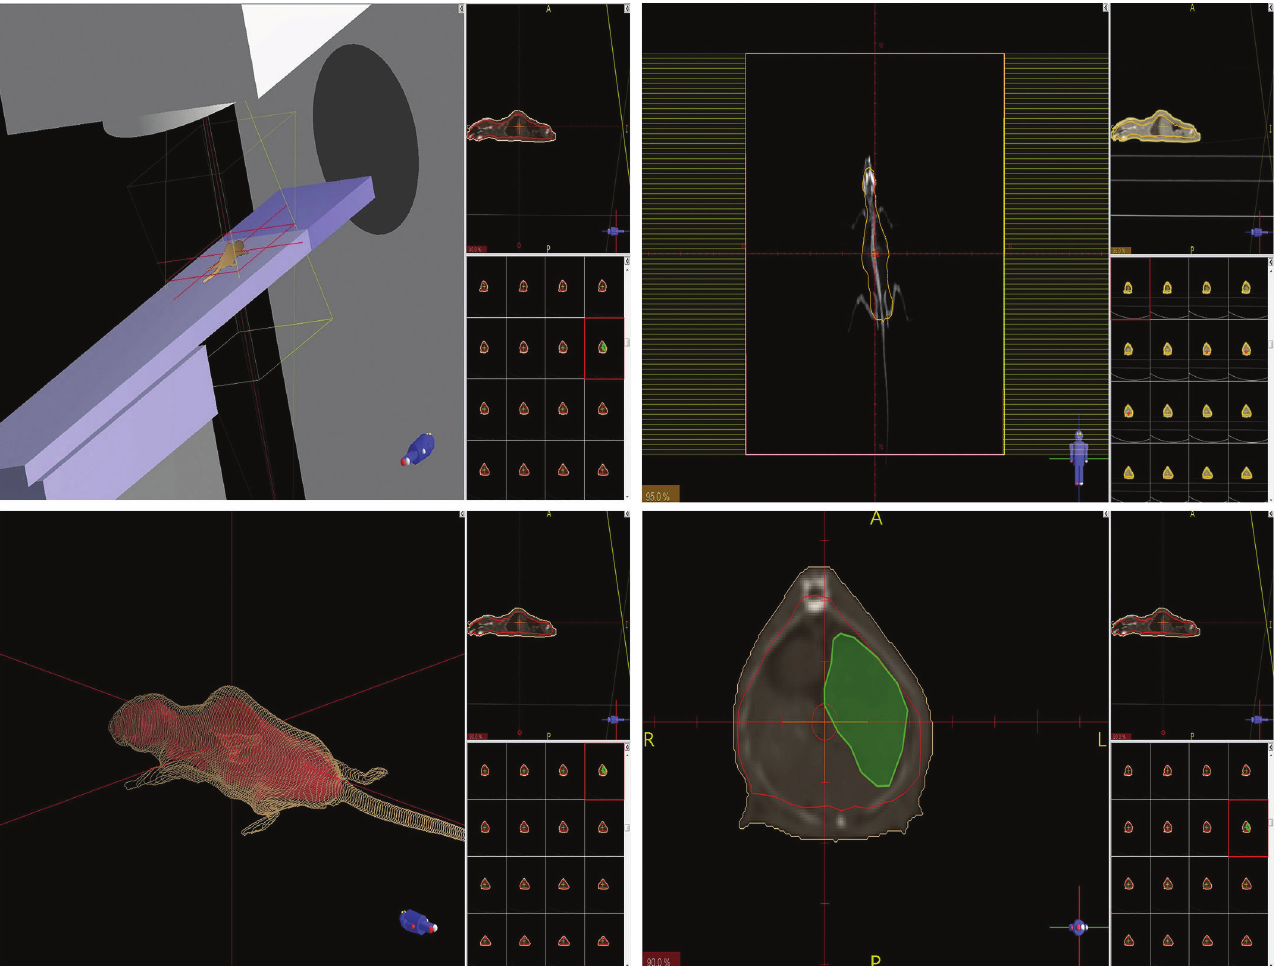
FIGURE 1 - Rat whole body three-dimensional (3-D) dose planning. Gantry 00 degrees beam angle and rat position. b) Irradiation field on the rat. c) 3-D radiation dose (5Gy) distribution on the rat. d) Contouring of the rat tissues and organs (green colored area: liver) in axial cross-sectional CT image (red line: field containing 5 Gy radiation dose). After the calculation of the radiation dose, the rats were placed and irradiated by a Linear Particle Accelerator SiemensTM Artiste (160 MLC) model LINAC using